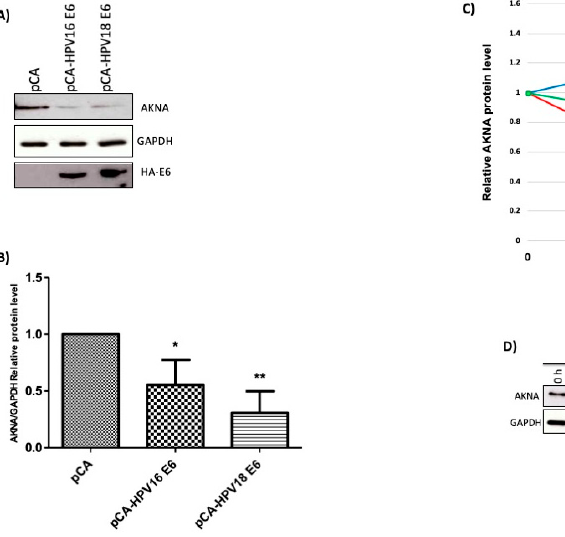
Figure 3. Cont. Figure 3.